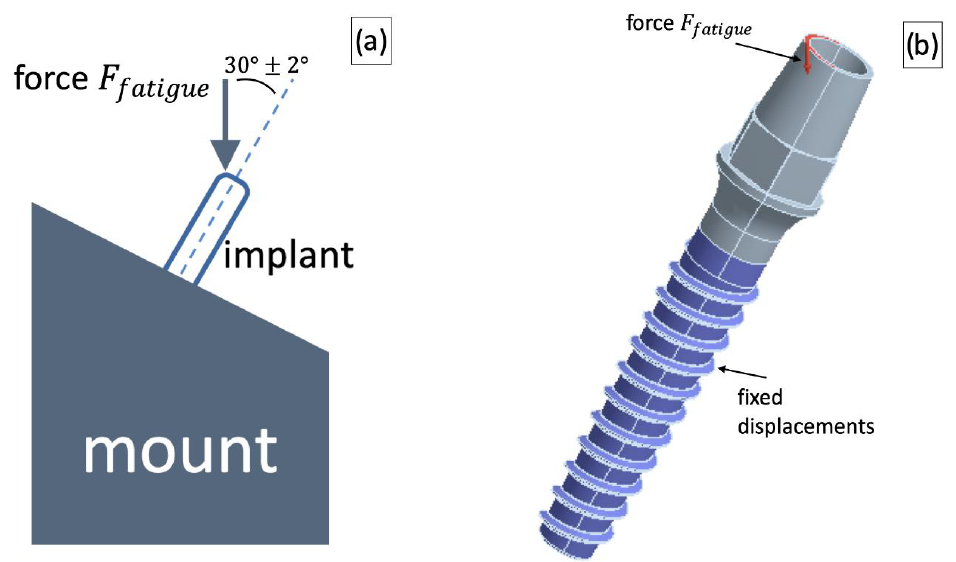
Figure 4. A loading scheme used for testing dental implants ( a ) and the corresponding CAD imple- mentation ( b ).